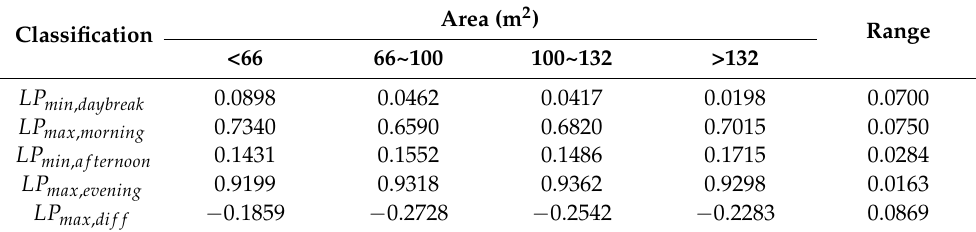
Table 2. Average feature value and range by area attribute.